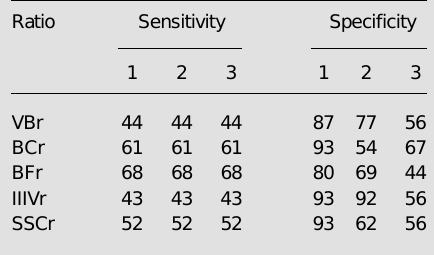
Table 7 - Analysis of brain measure correlations, individually and in a stepwise- stratified way (dementia and